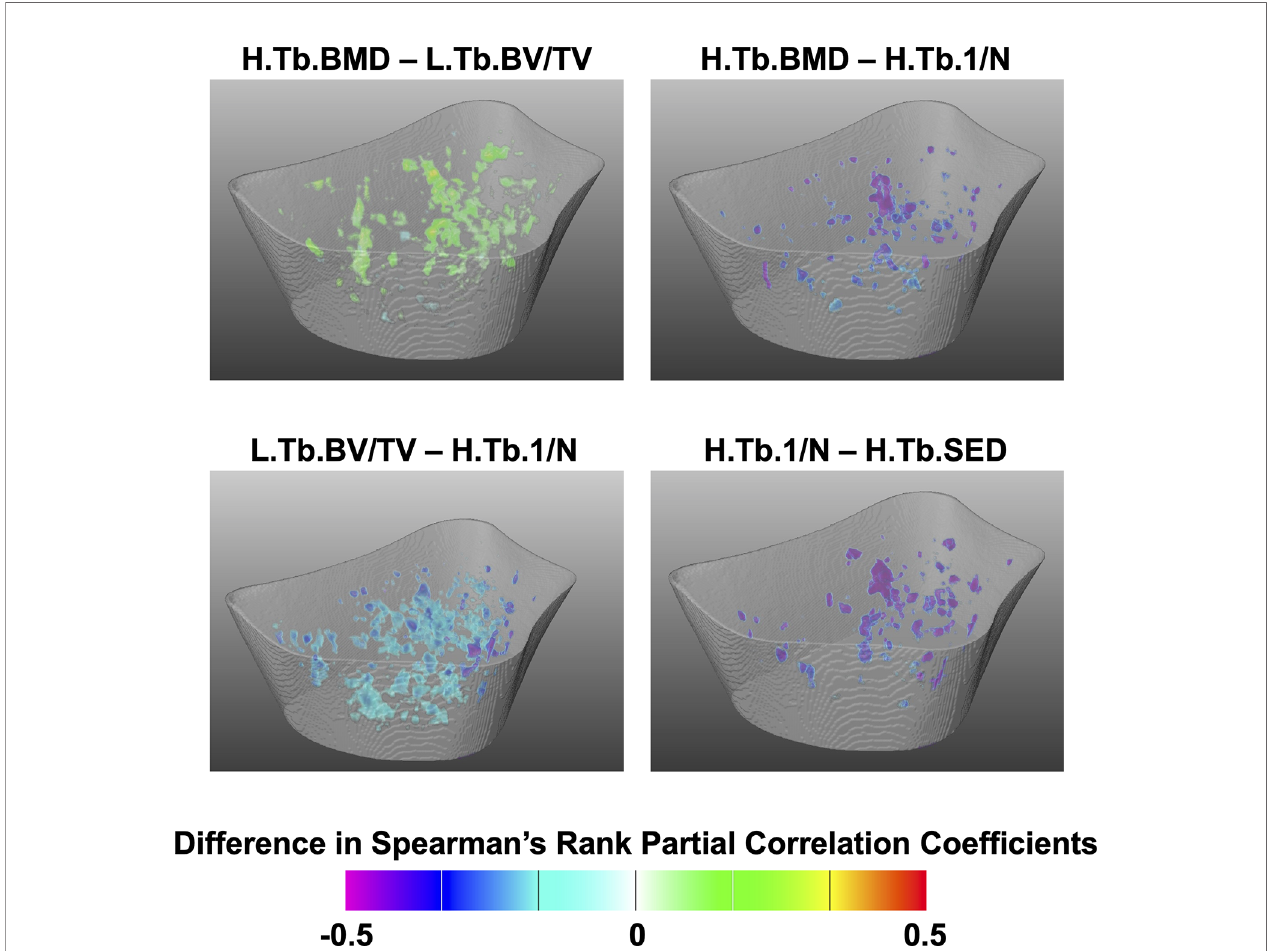
FIGURE 4 | Assessment of spatial differences of interrelationships of trabecular bone parameters between controls and fracture cases. Three-dimensional statistical maps showing voxels for which the Spearman ’ s rank partial correlation coef fi cients were signi fi cantly different between fracture cases and controls. Signi fi cant voxels are showing the difference of correlation coef fi cients (fracture cases minus controls), and nonsigni fi cant voxels were rendered